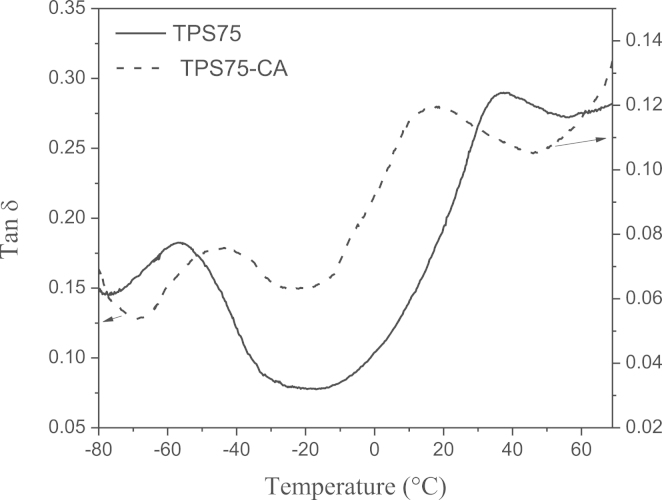
Loss tangent, tanδ, as a function of the temperature of TPS75 and TPS75-CA films.